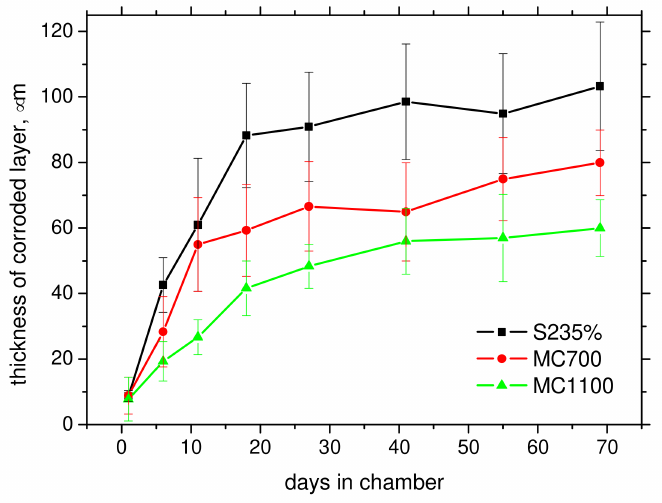
Figure 4. Evolution of the thickness of the corroded